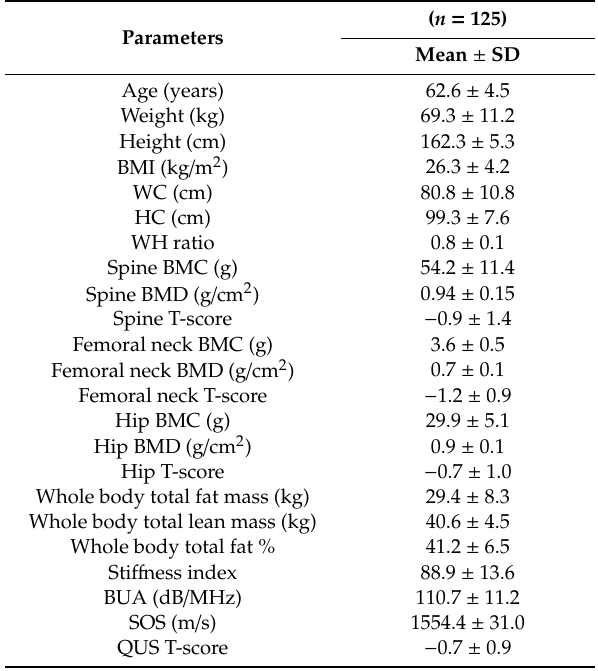
Table 1. The subjects’ baseline characteristics and anthropometric